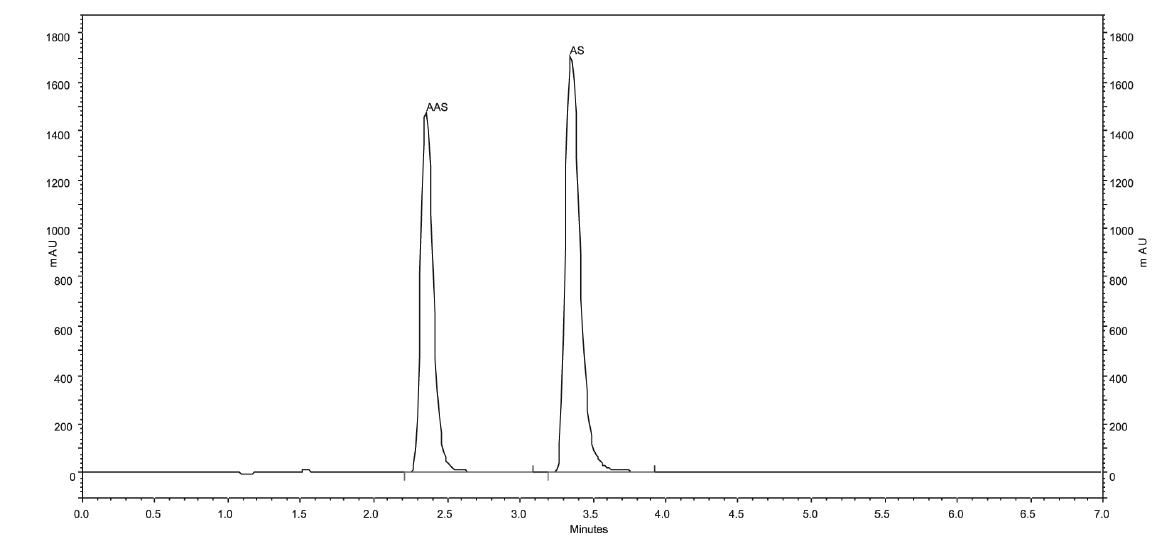
FIGURE 2 - Chromatograms of acetylsalicylic (0.505 mg/mL) and salicylic acids (0.511 mg/mL), injected in the Shimadzu chromatograph with DAD*. AAS – retention time: 2.36 min; area: 8998285; plate number: 3191; enlargement factor: 1.21; retention factor: 1.62. AS – retention time: 3.35 min; area: 12441463; plate number: 4341; resolution: 5.36; enlargement factor: 1.44; retention factor: 2.72.